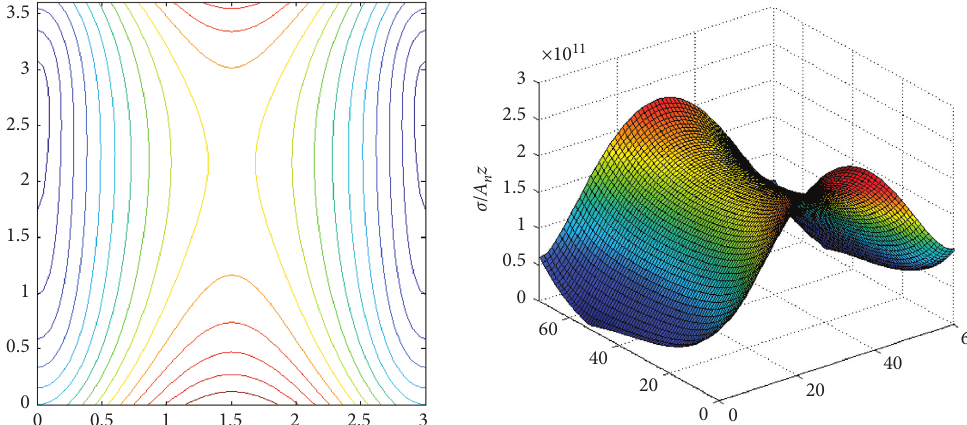
Figure 11: The maximum shear of the 1 st order mode